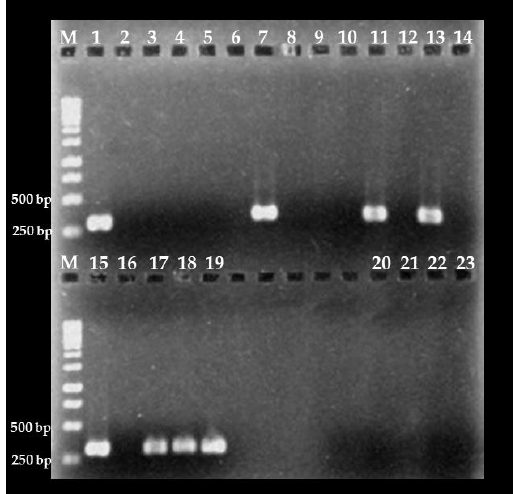
Figure 3. Detection of Cyclospora cayetanensis in berry and soil samples from Mexican farms. Lanes 1 to 3: blueberry; lanes 4 to 6: raspberry; lanes 7 to 14: blackberry samples; and lanes 15 and 16: soil samples. Lanes 17 to 19: C. cayetanensis DNA as positive control and lanes 20 to 23: water PCR grade as negative control. M: molecular weight marker.